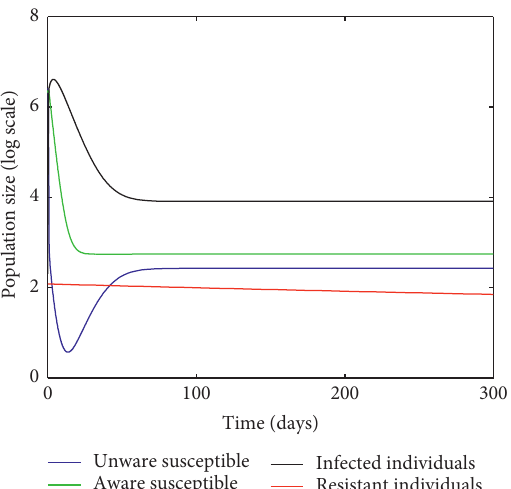
Figure 4: Global stability of the endemic steady state with initial variables S ∗ β � 0 . 0147; remaining parameter values are given in Table 1.